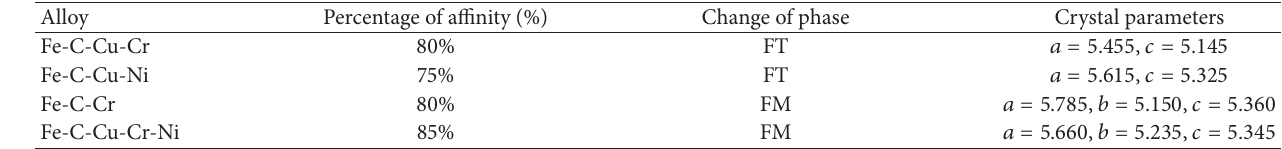
Figure 6: Simulation of the motor speed control for the biomechanical system made of SS 304. Table 2: Characterization of phases of alloys for coatings in carbon steels.